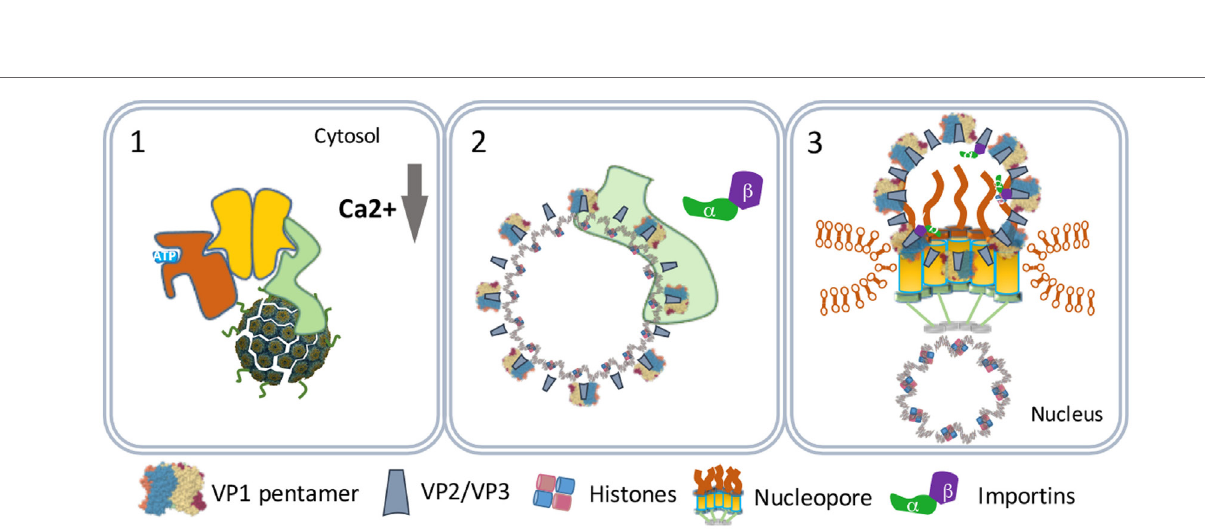
FigURe 4 | The traffic of SV40 particles from the endoplasmic reticulum (ER) to the cytosol. SV40 particles are destabilized by the ER-associated degradation machinery (1) and remain associated with the ER membrane (2). But instead of leaving the ER by binding Hrd1 and to be loaded to cytoplasmic proteasomes (3), the destabilized particles interact with ER membrane-resident proteins (4) and associate with cytosolic chaperones (5) to move to the cytosol (6).